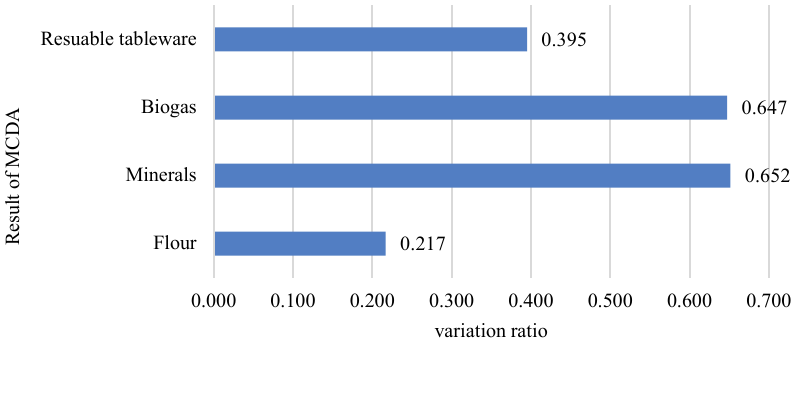
Fig. 7. Summary results of the alternatives with the highest added value for each assessed